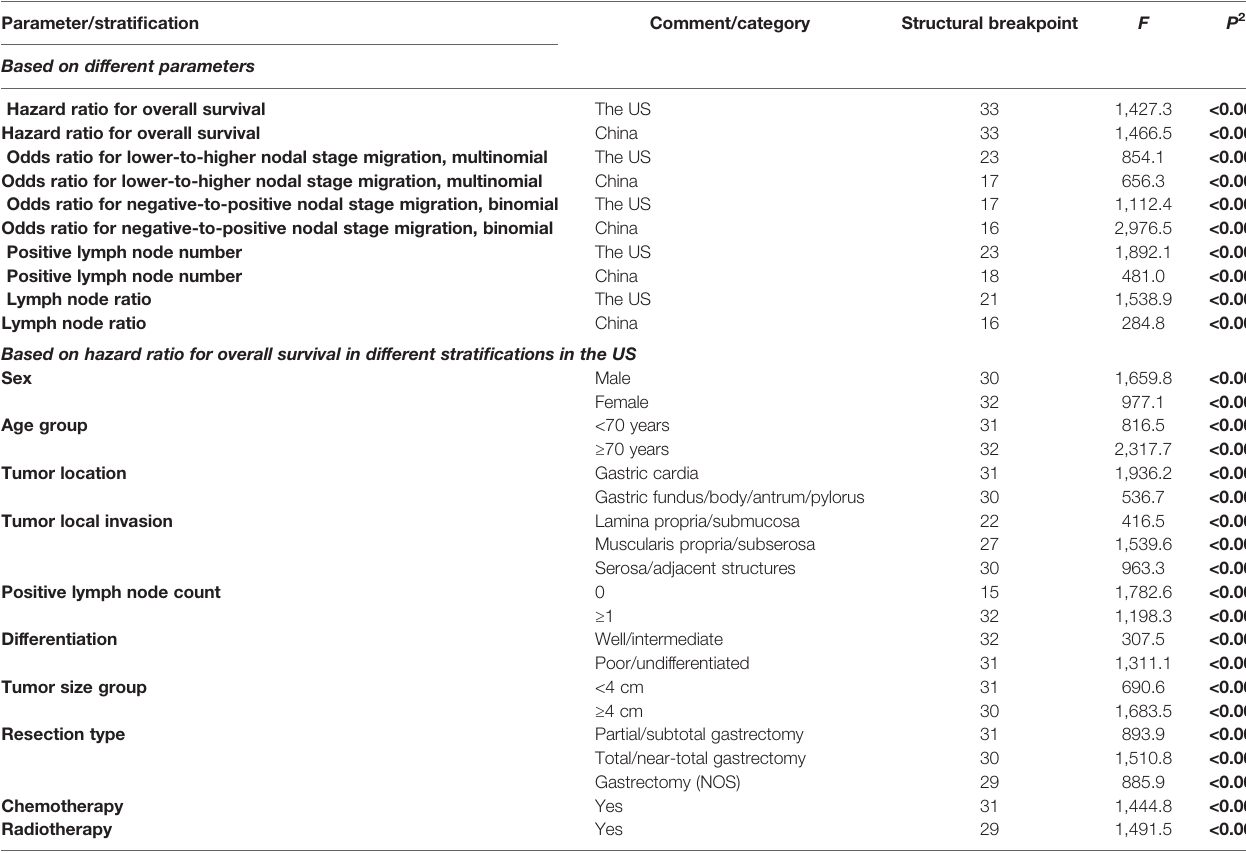
TABLE 4 | Structural breakpoints of examined lymph node count based on different parameters and based on hazard ratio for overall survival in different subgroups 1 . Parameter/strati fi